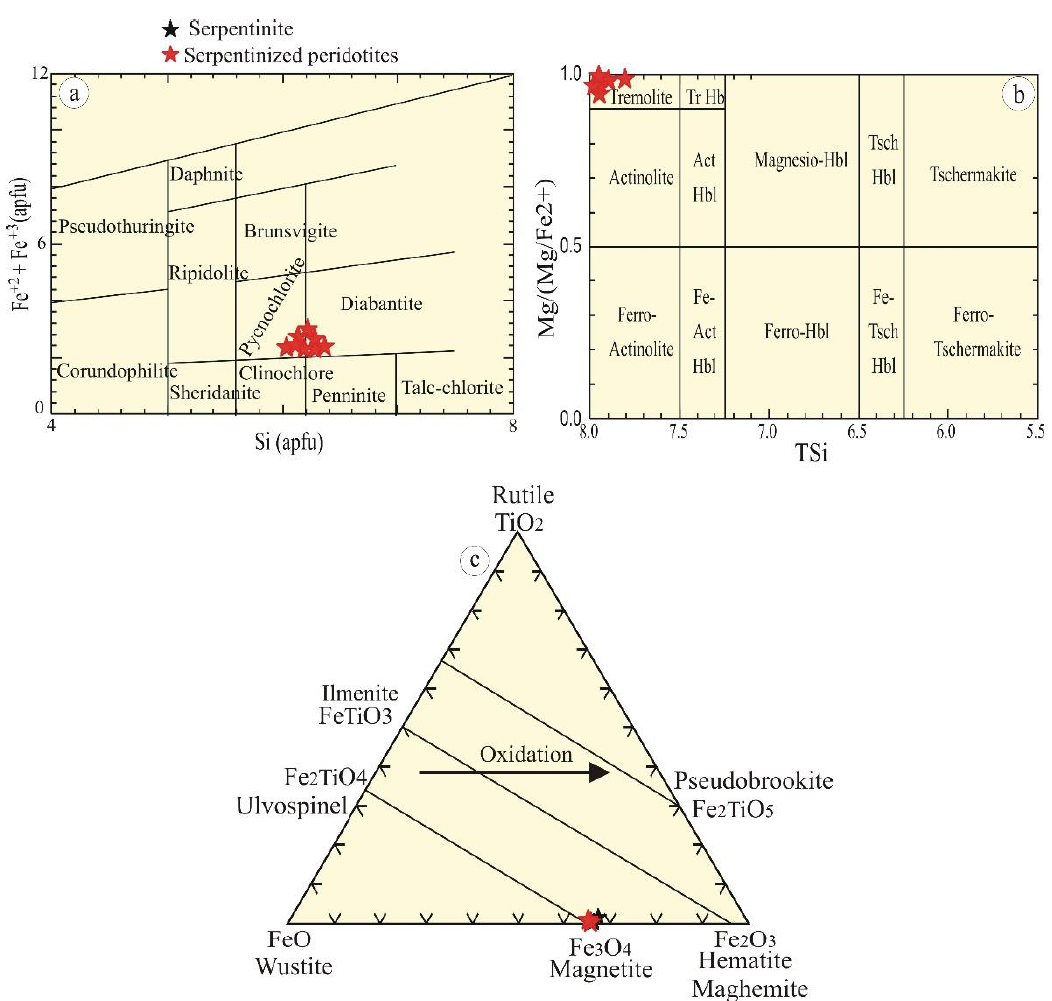
Figure 7. ( a ) Nomenclature diagram of chlorite from [35]; ( b ) TSi (apfu) vs. Mg# discrimination diagram [40]; and ( c ) FeO- TiO 2 -Fe 2 O 3 discrimination diagram of magnetite and ilmenite.